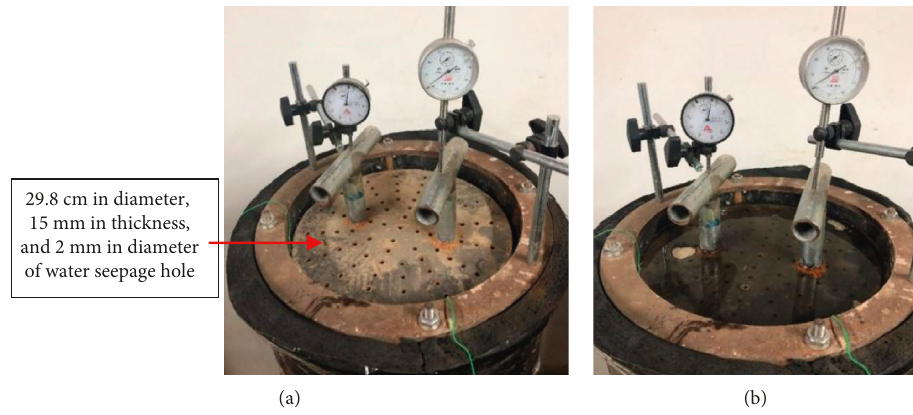
Figure 11: Diagram of simulating precipitation. (a) Before adding water. (b) After adding